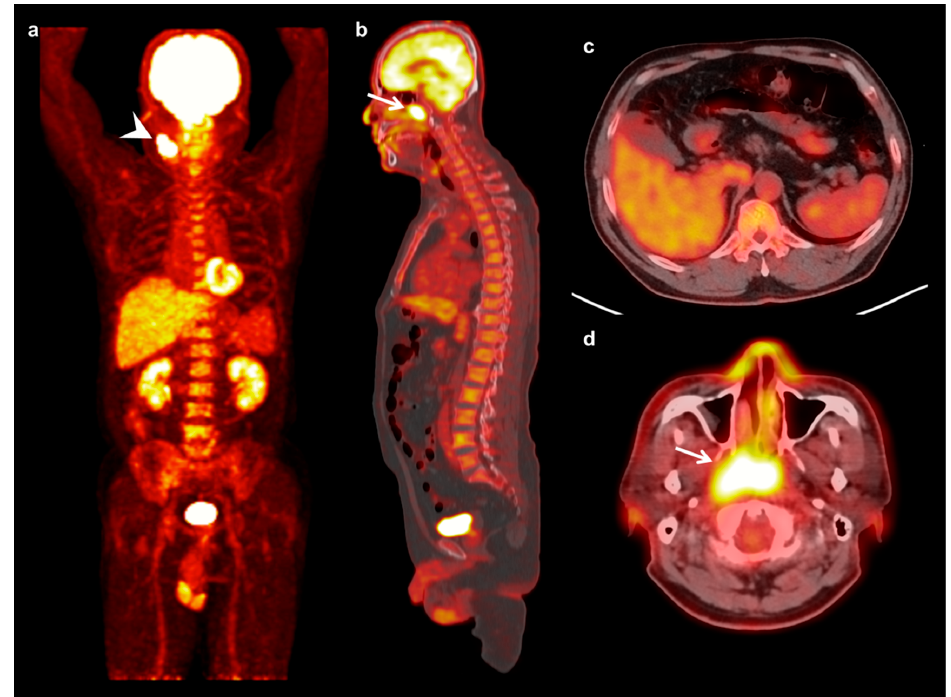
Figure 2. Maximum intensity projection ( a ) and sagittal ( b ) FDG PET images and fused transaxial FDG PET/CT images ( c , d ) of a 57-year-old man with nasopharyngeal cancer. A 5.3 cm-sized mass in the right nasopharynx showed intensely increased FDG uptake (arrow) (maximum SUV